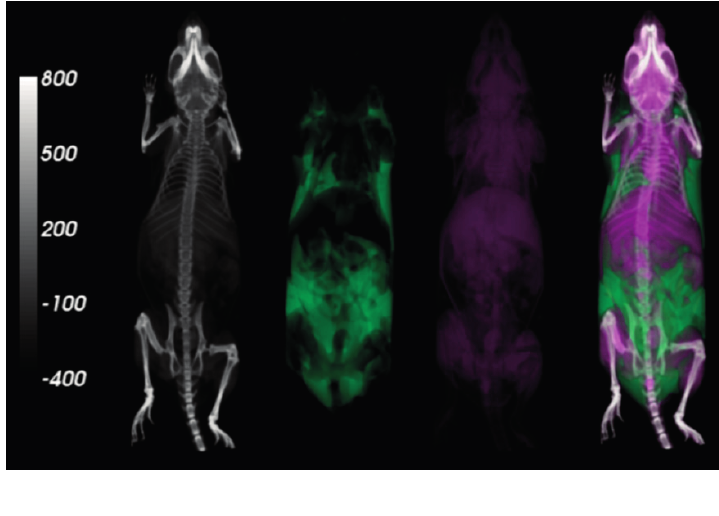
Figure 5. Three-dimensional visualizations of: ( a ) all skeletal and soft tissue; ( b ) region-specific adiposity; ( c ) lean tissue; and ( d ) an overlay of the three in a mouse from Cohort A at the 6 week time